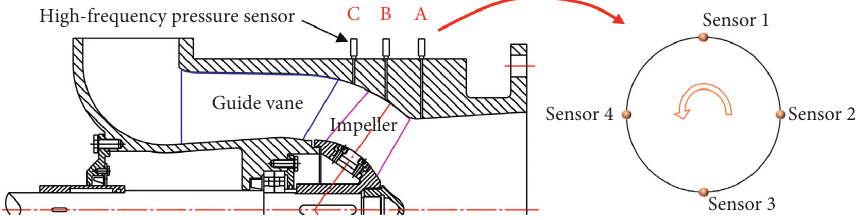
Figure 3: Mixed-flow pump